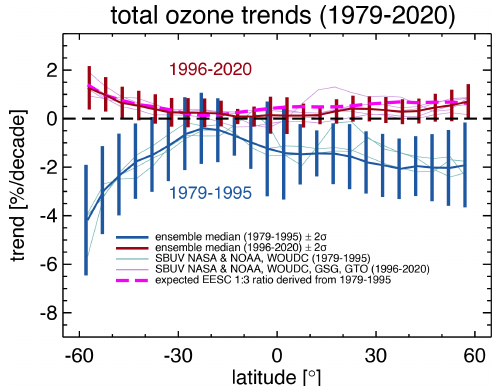
Figure 3. Latitude-dependent ozone trends in steps of 5 ◦ from ap- plying the full MLR (Eqs. 1 and 4) to the median time series of the five merged total ozone datasets. Trends and 2 σ standard deviations are shown in blue for the time period before 1995 and in red after 1995. The thin lines show the trends of the individual total ozone datasets. The dashed pink lines are the post-ODS peak trends as ex- pected from the 1:3 ratio (corresponding to changes in the strato- spheric halogen), applied to the median time series’ trends before